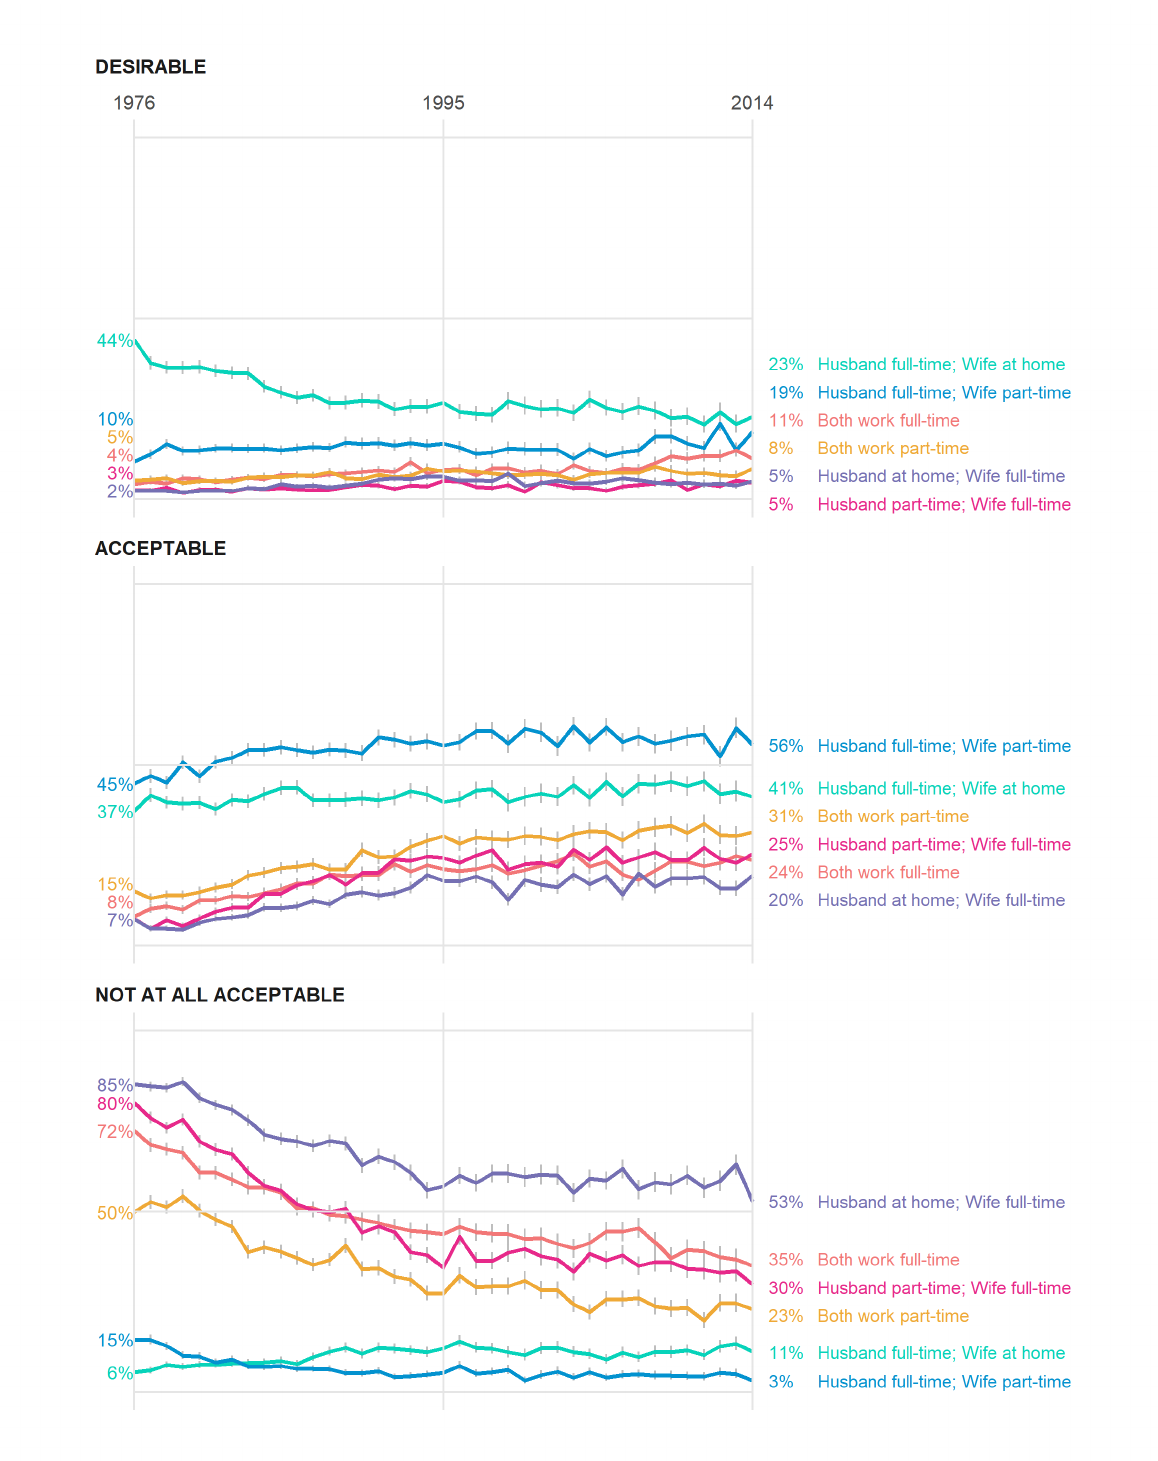
Figure 1: Young adults’ expectations of the division of work and family labor. Note that the “Somewhat Acceptable” response is not